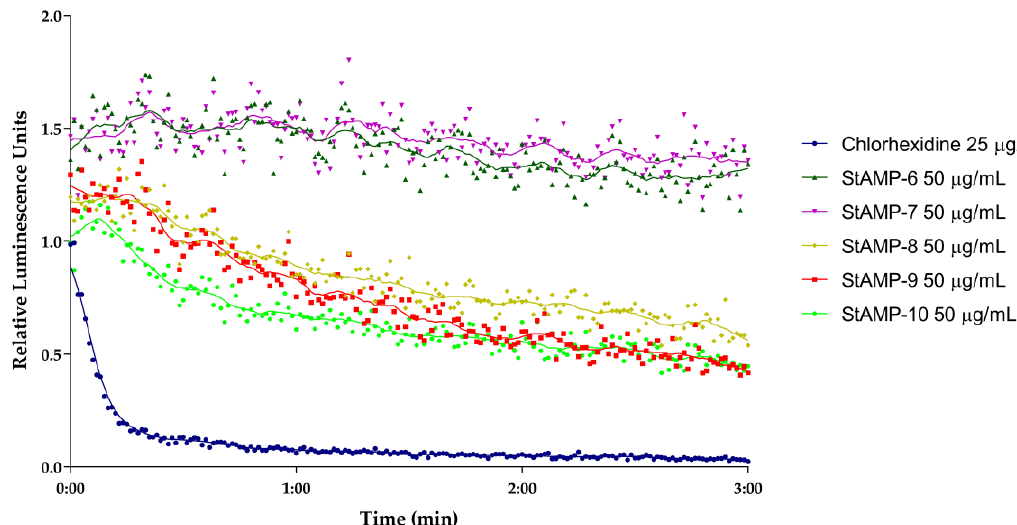
Figure 5. Kinetics of the antimicrobial effect on viability of B. subtilis 168 as measured by relative luminescence emission from the luxABCDE operon after adding StAMP-6-10 to the bacteria. Chlorhexidine served as a positive control and water as a negative control. Each datapoint was the mean of three independent measurements normalized to the negative control.